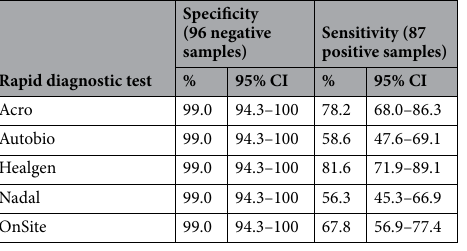
Table 1. Specificity and sensitivity of five SARS-CoV-2 rapid diagnostic antibody tests. CI confidence